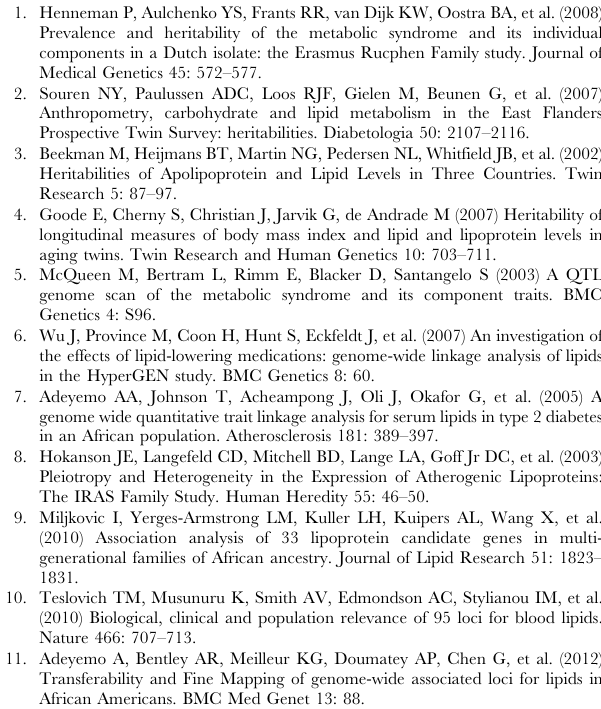
Table S3 Local ancestry interactions among serum lipids- associated LPL variants. Associations between Serum Lipids- associated LPL variants within Local Ancestry Strata. Table S4 Primers used. Further details on the set of primers used for novel genotyping of variants discovered in the sequencing stage. Table S5 Description of included variants. Description of all variants included in the genotyping stage of